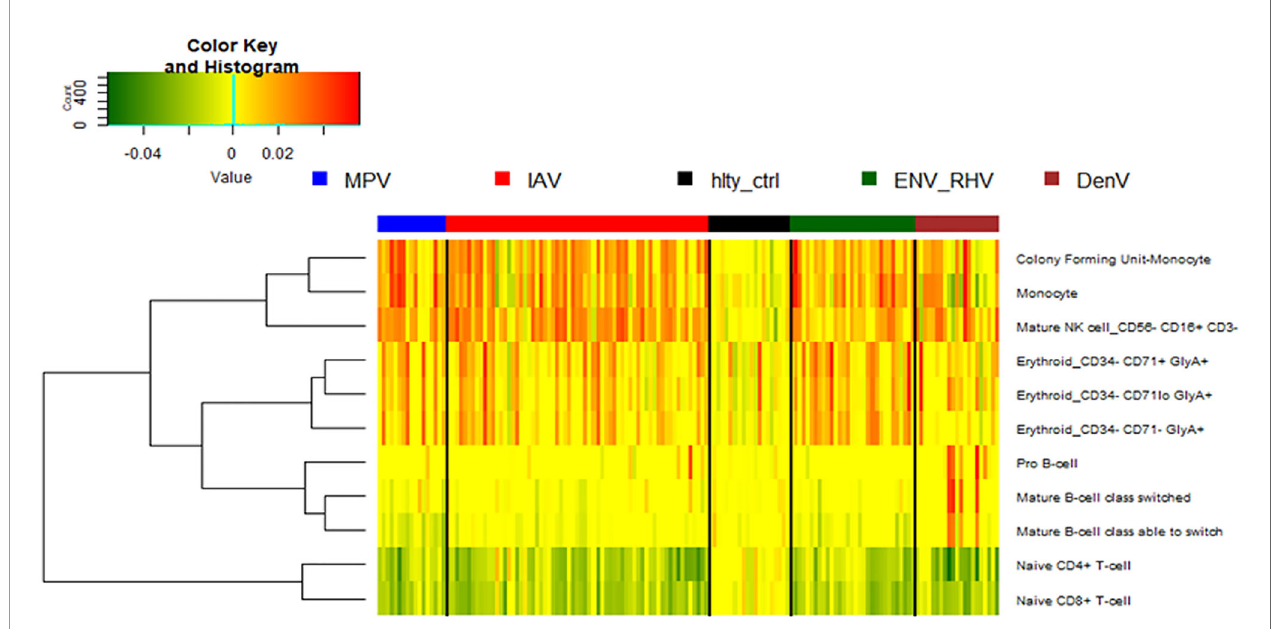
FIGURE 9 | Digital cell quanti fi cation. Using digital cell quanti fi cation, immune cells were quanti fi ed based on gene expression levels. The relative abundance of immune cell populations is presented as a heatmap. Shown are only cell populations that exhibited differences across any infected/healthy group. IAV, in fl uenza virus; ENV_RHV, enterovirus/rhinovirus; MPV, metapneumovirus; DenV, dengue